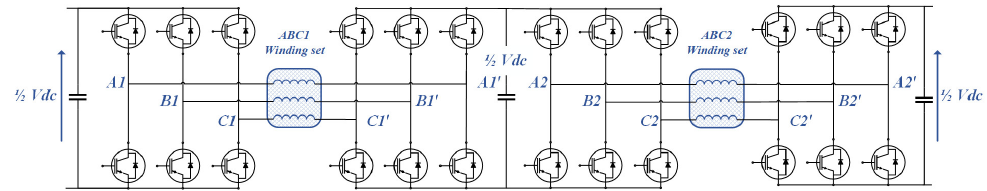
Figure 25. Open-end winding six-phase topology with quadruple two-level three phase inverters and triple dc sources (topology III).